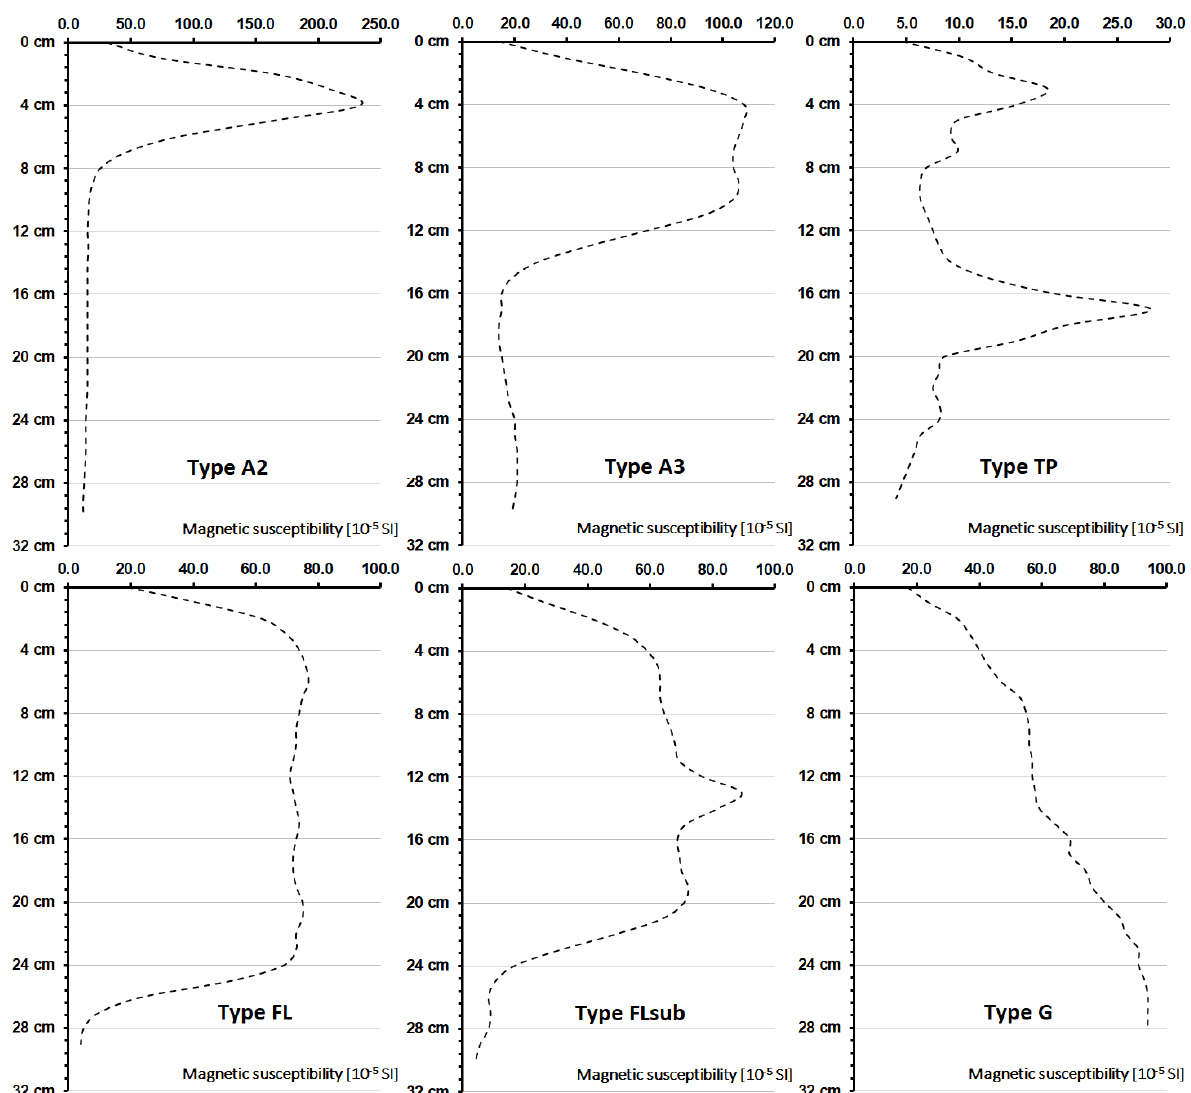
Figure 5. Types of κ distribution in soil profile that were determined on the basis of collected soil